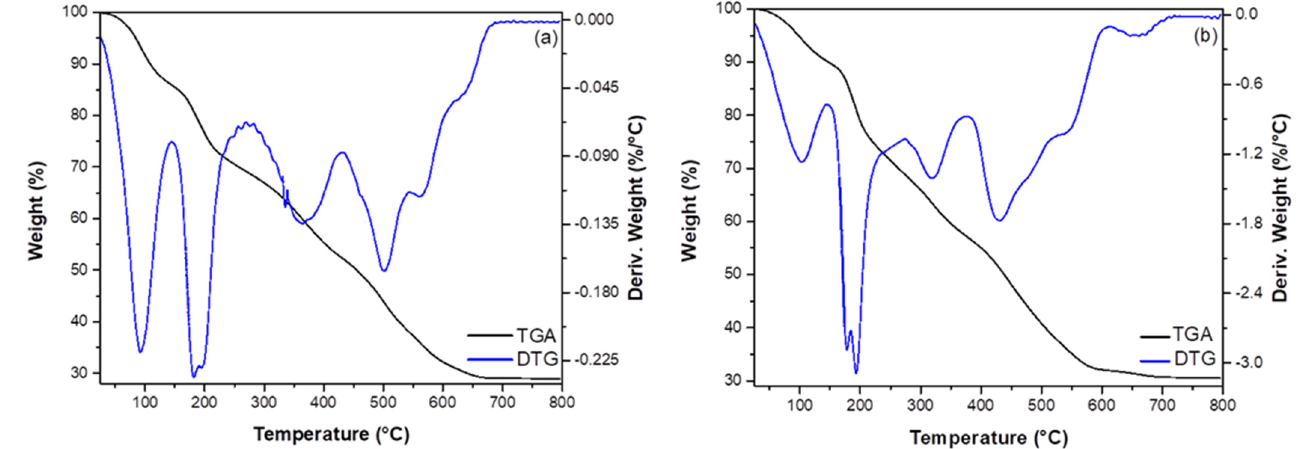
Figure 3. Thermogravimetric analysis of ( a ) ZGluGO and ( b ) ZAspGO samples. DSC (differential scanning calorimetry) curves (Figure 4) for the adsorbent materials suggest the decomposition of ZGluGO and ZaspGO through an endothermic weight loss process that maximizes at 109.1 °C and 107.8 °C, respectively. This endothermic process is related to the dehydration of the sample, as well as the partial decomposition of the organic part. Subsequently, exothermic processes occur at 177.5, 331.7, 502.6, 562.6, and 633.6 °C for ZgluGO and at 178.8, 341.4, 483.4, 544.9, and 662.4 °C for ZaspGO, which may be related to the pyrolysis of the material, as well as dehydroxylation and crystallization of zirconium during heating [47].